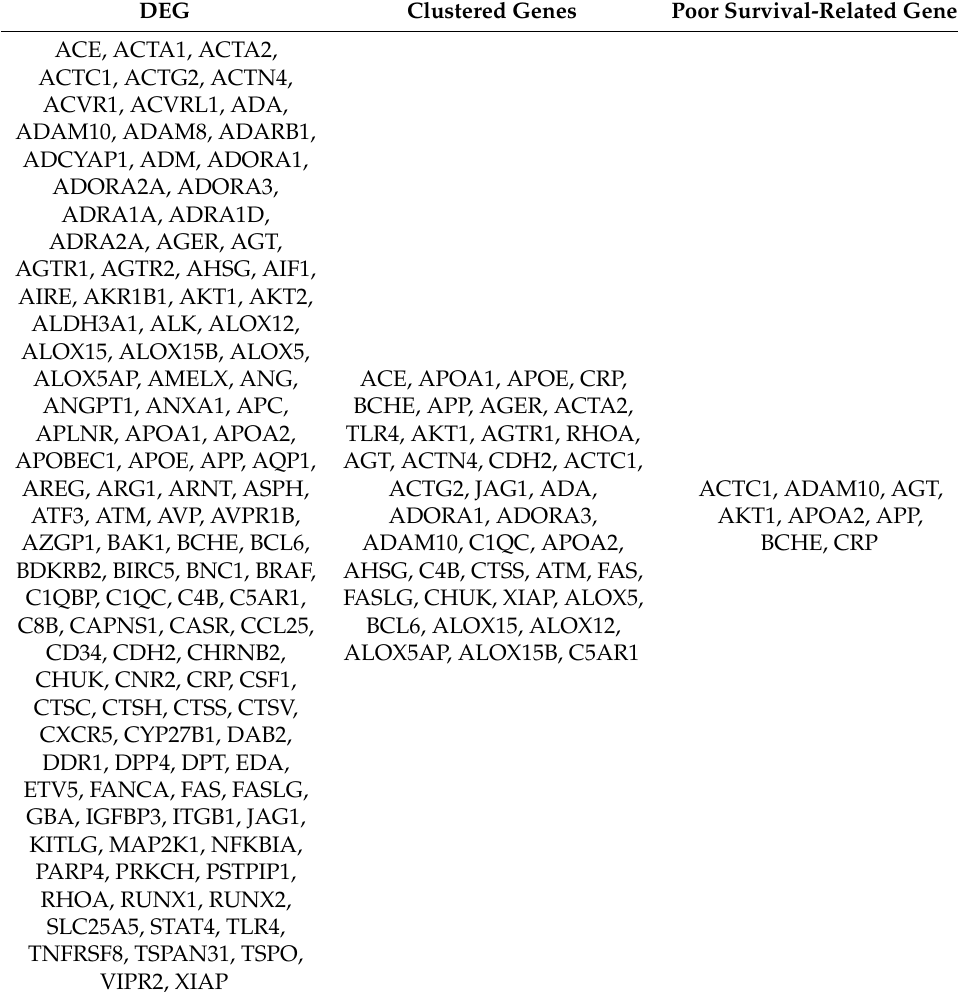
Table 1. Bioinformatic Selection of Genes. DEG Clustered Genes Poor Survival-Related Genes